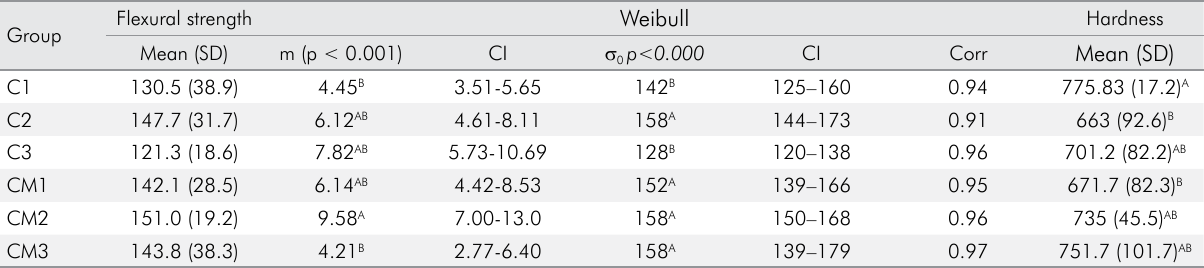
Table. Means and standard deviation (SD) of mechanical properties of the groups. Characteristic strength ( σ 0), Weibull modulus (m) and respective coefficient intervals (CI), and correlation for flexural strength. Group